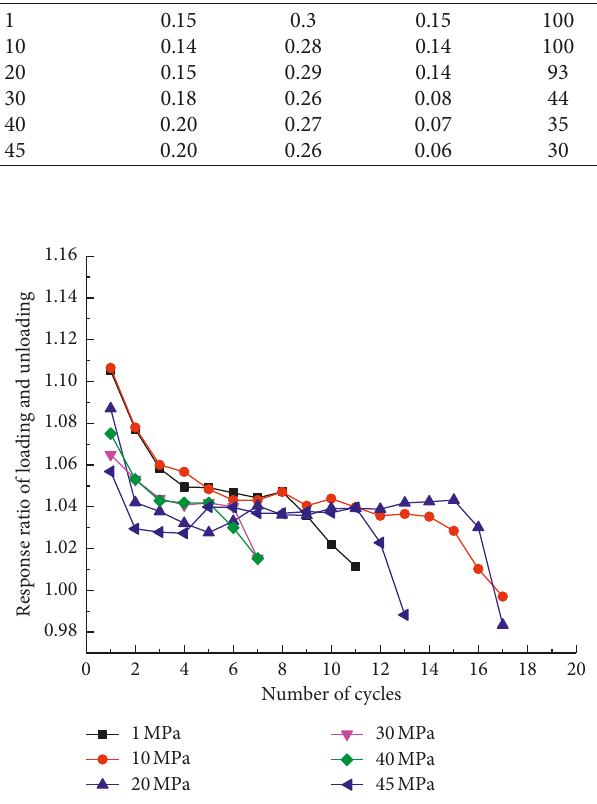
Figure 16: Variation of loading/unloading response